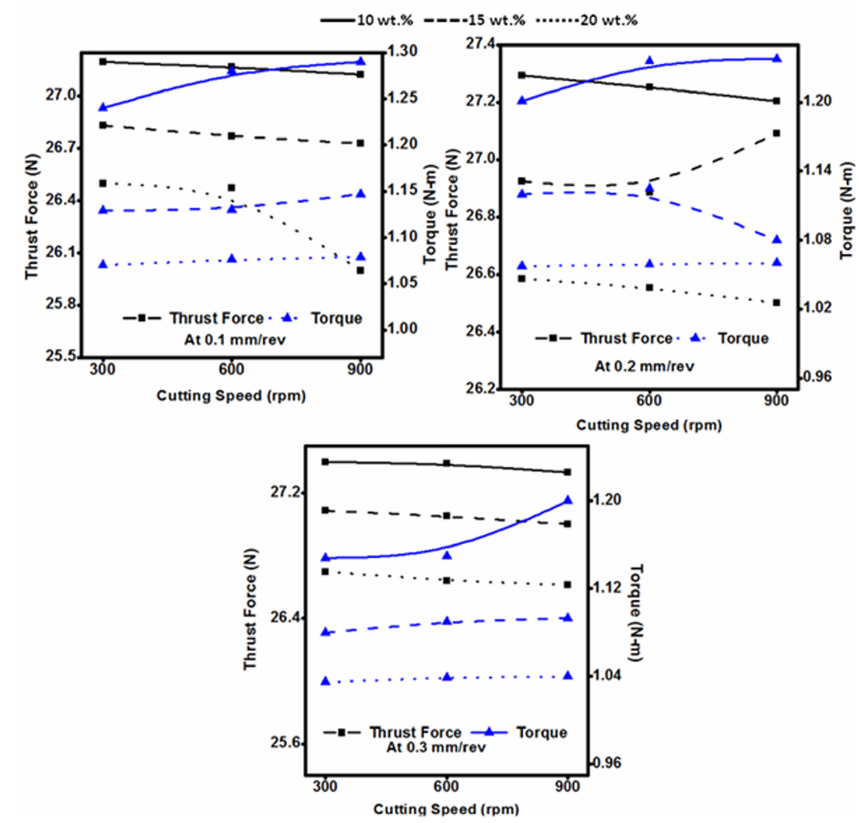
Figure 5: Effect of cutting speed, wt.% and feed rate on thrust force and torque for Hybrid RH reinforced composites Table 2: ANOVA data for thrust force and torque for hybrid RH reinforced Composite ANOVA analysis for thrust